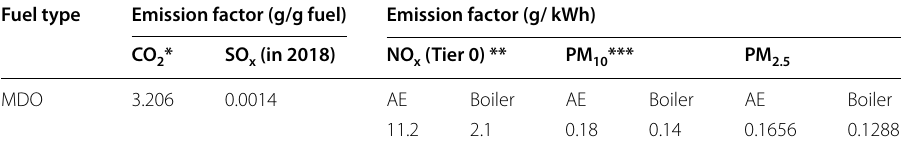
* IMO 2018 ** Used as for the lack of data in IMO (2020) *** Generation III engines considered and year 2018